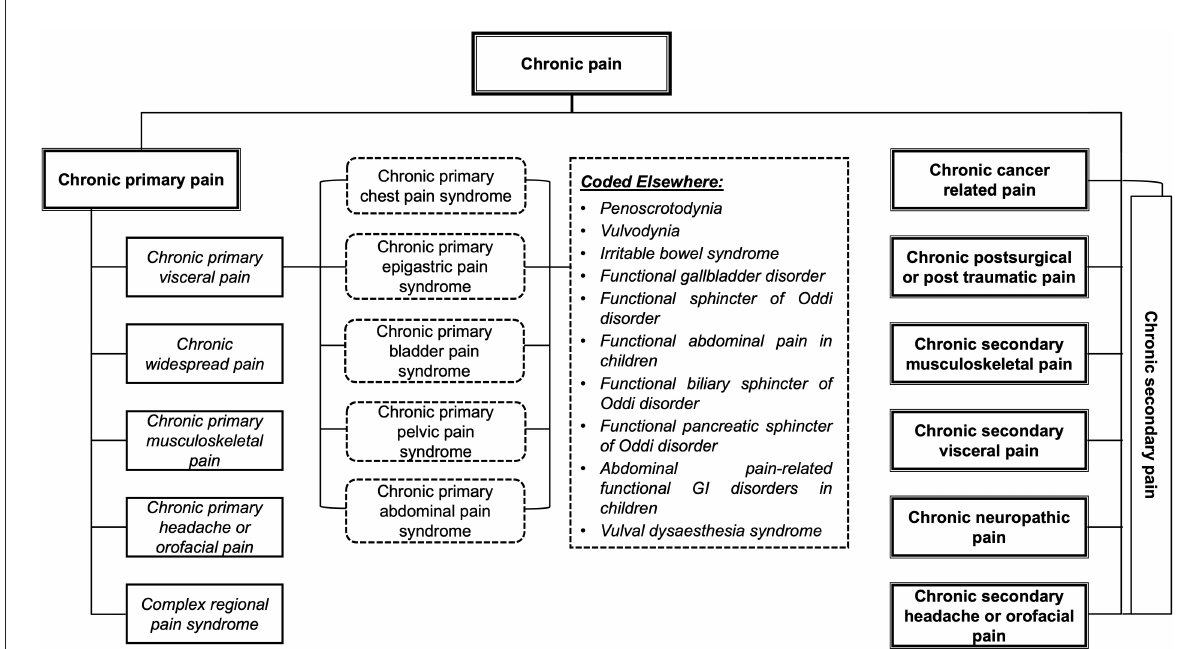
FIGURE1 Classification of chronic pain: chronic primary pain and chronic secondary pain. Version adapted from Treede et al.